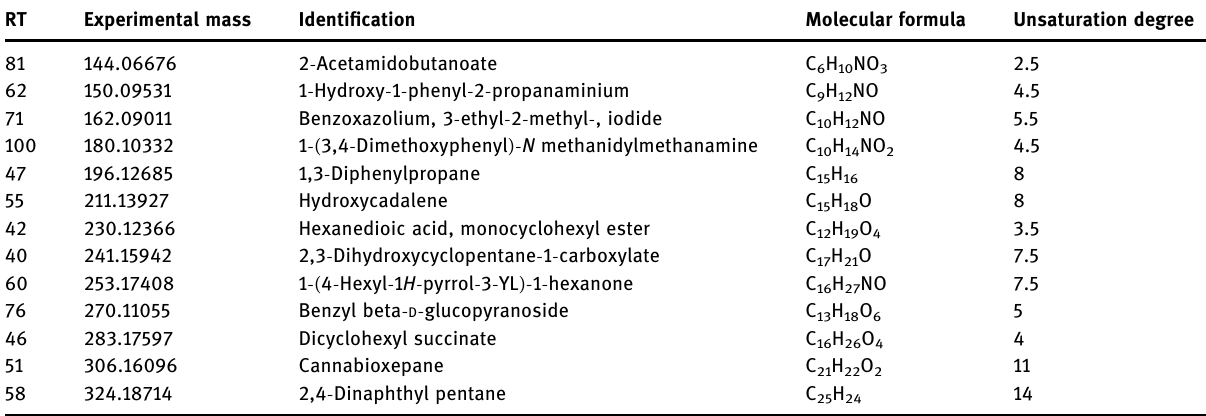
Table 1: Identi fi cation of phytochemical compounds by DART – ToF - MS in CPLE. RT, retention time RT Experimental